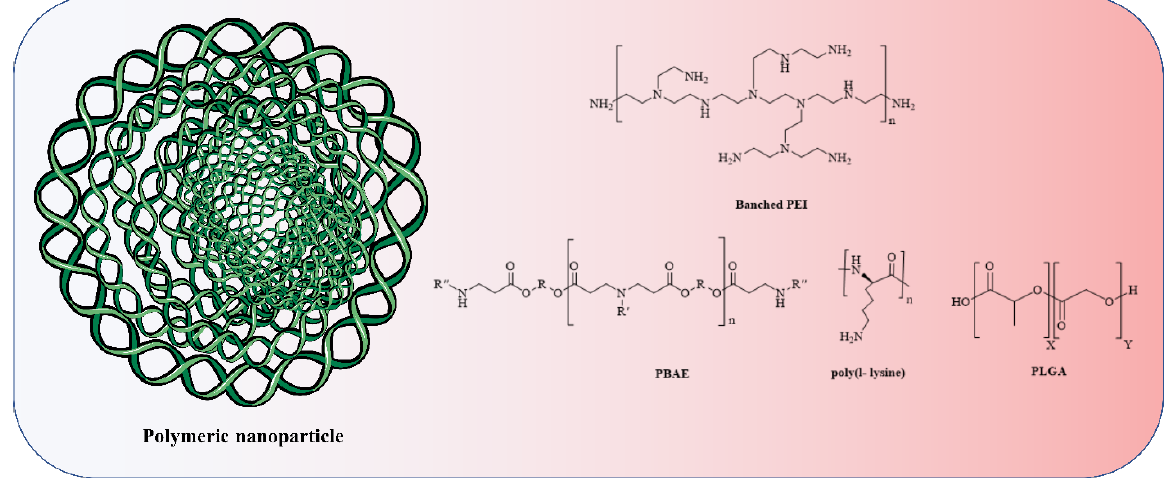
Figure 5. The anionic phosphodiester part of RNA is complexed by cationic amine groups (due to attachment of a proton) in polymeric nanoparticles and polymers based on poly(ethylenimine) (PEI), poly(l-lysine) (PLL), and poly(beta-amino ester) (PBAE). Polymers derived from poly(lactic-co-glycolic acid) (PLGA) are commonly modified to incorporate discrete cationic groups.